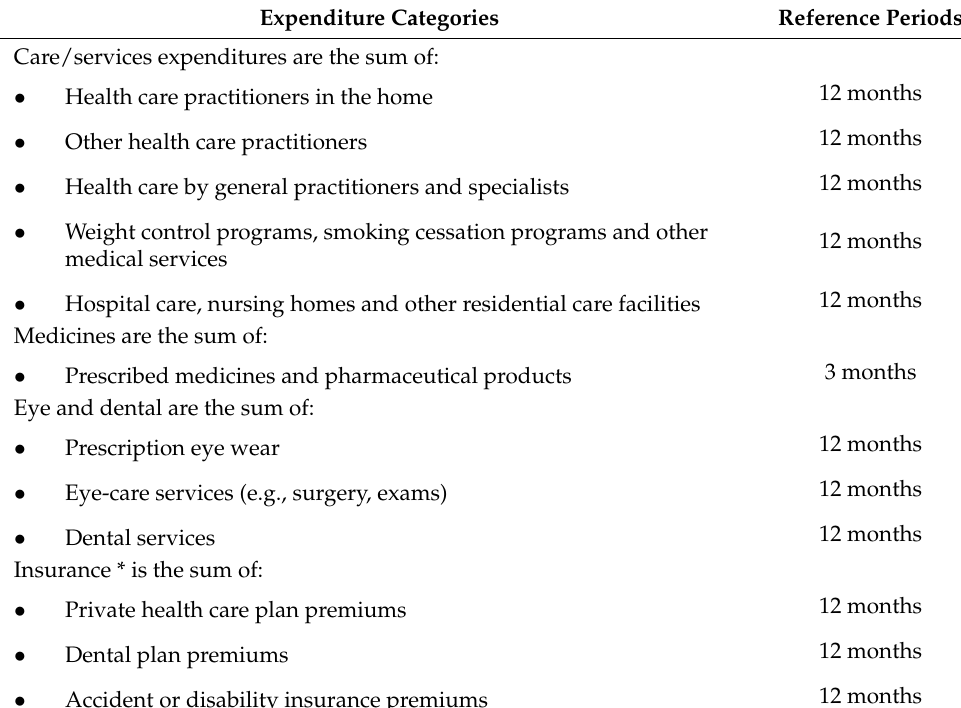
Table 1. Items included in expenditure